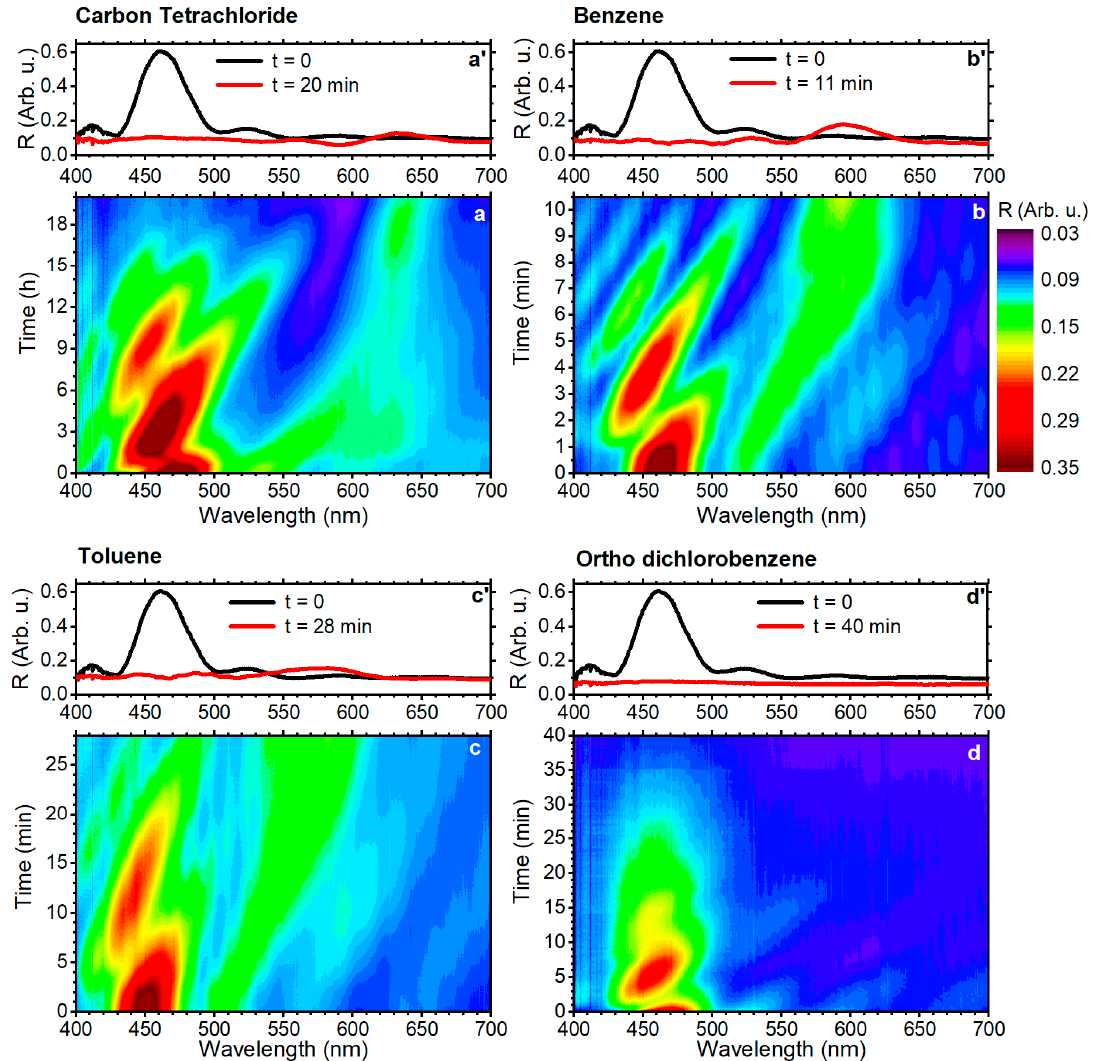
Figure 2. Optical response of the DBR sensors to vapors. The bottom panel reports the dynamic responses as contour plots ( a – d ). The top panels ( a’ – d’ ) show the spectra collected before and after the exposures for carbon tetrachloride (CTC) ( a , a’ ), benzene (BEN) ( b , b’ ), toluene (TOL) ( c , c’ ), and 1,2-dichlorobenzene (o-DCB) ( d , d’ ).